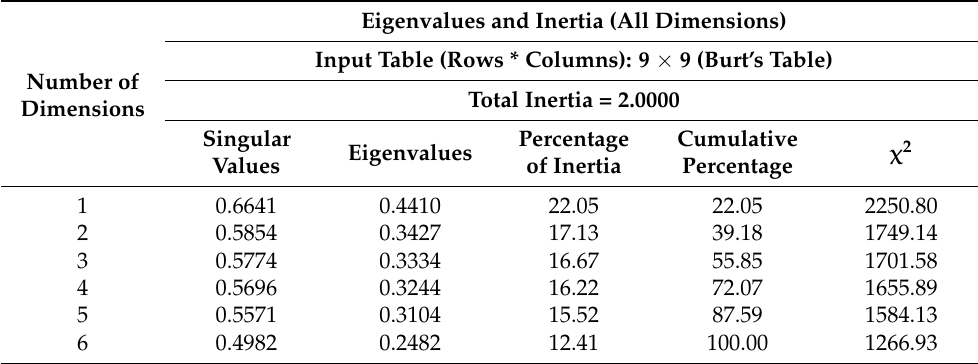
Table 5. Eigenvalues and inertia for all dimensions relating to country, period of use of the largest quantity of tap water supplied and the use of tap water directly for drinking without boiling. Eigenvalues and Inertia (All Dimensions) Input Table (Rows * Columns): 9 × 9 (Burt’s Number of Dimensions